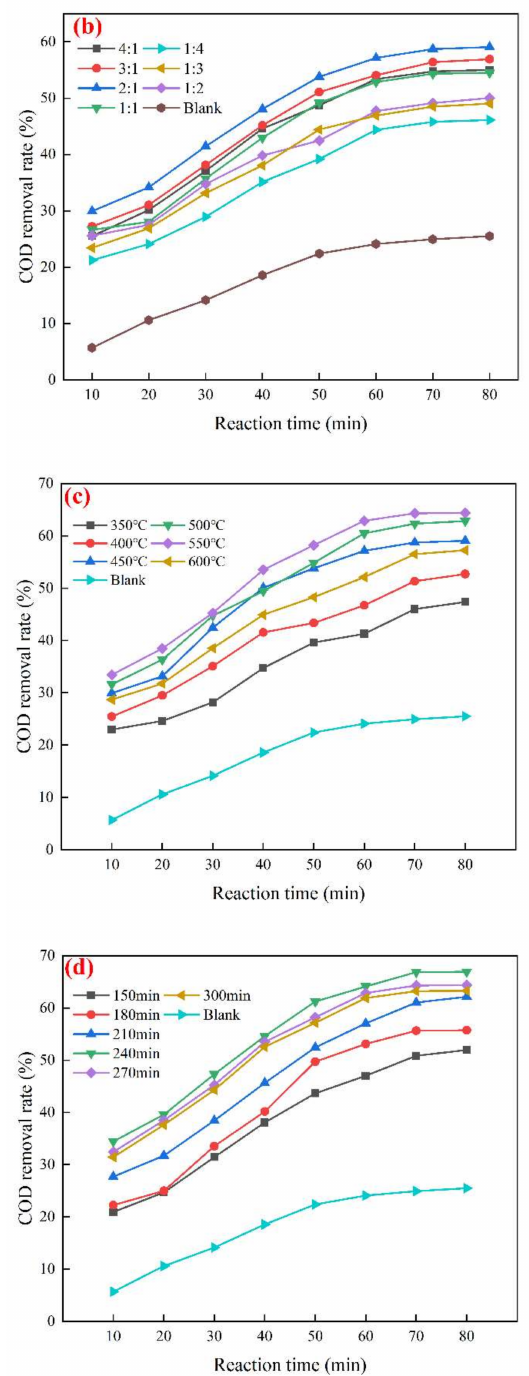
Figure 1. Effect of different preparation conditions on COD removal rate: ( a ) Effect of different reac- tion systems on COD removal rate; ( b ) Effect of Mn:Ce doping ratio on COD removal rate, ( c ) Effect of roasting temperature on COD removal rate; ( d ) Effect of roasting time on COD removal